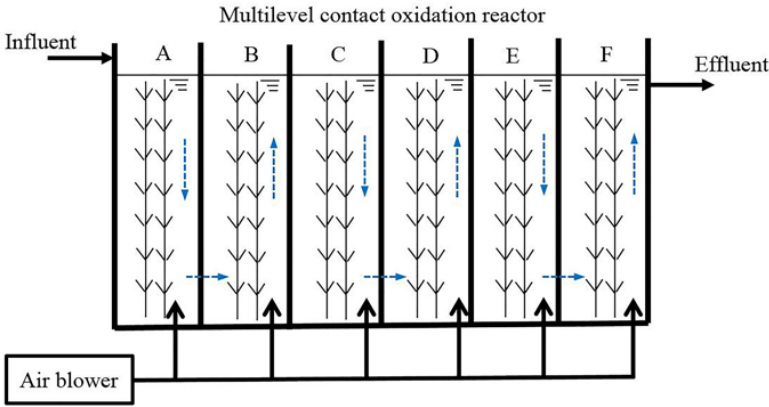
Figure 2. Experimental system of the multi-level contact oxidation process.